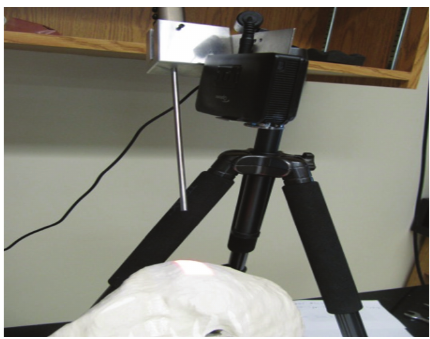
Figure 1: Experimental setup for stereo endoscope and liver phantom.